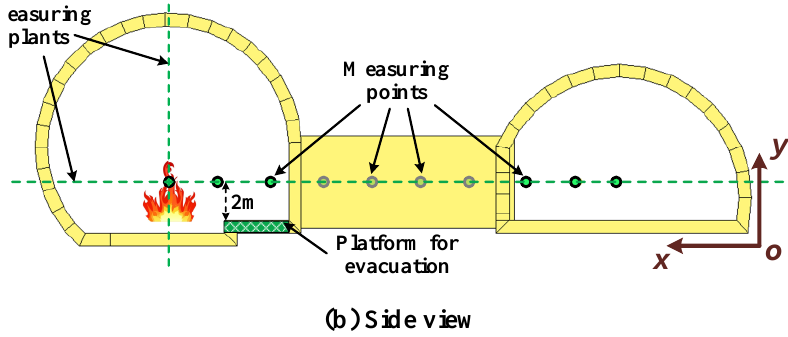
Figure 1. Simulation model: ( a ) Top view; ( b ) Side view.